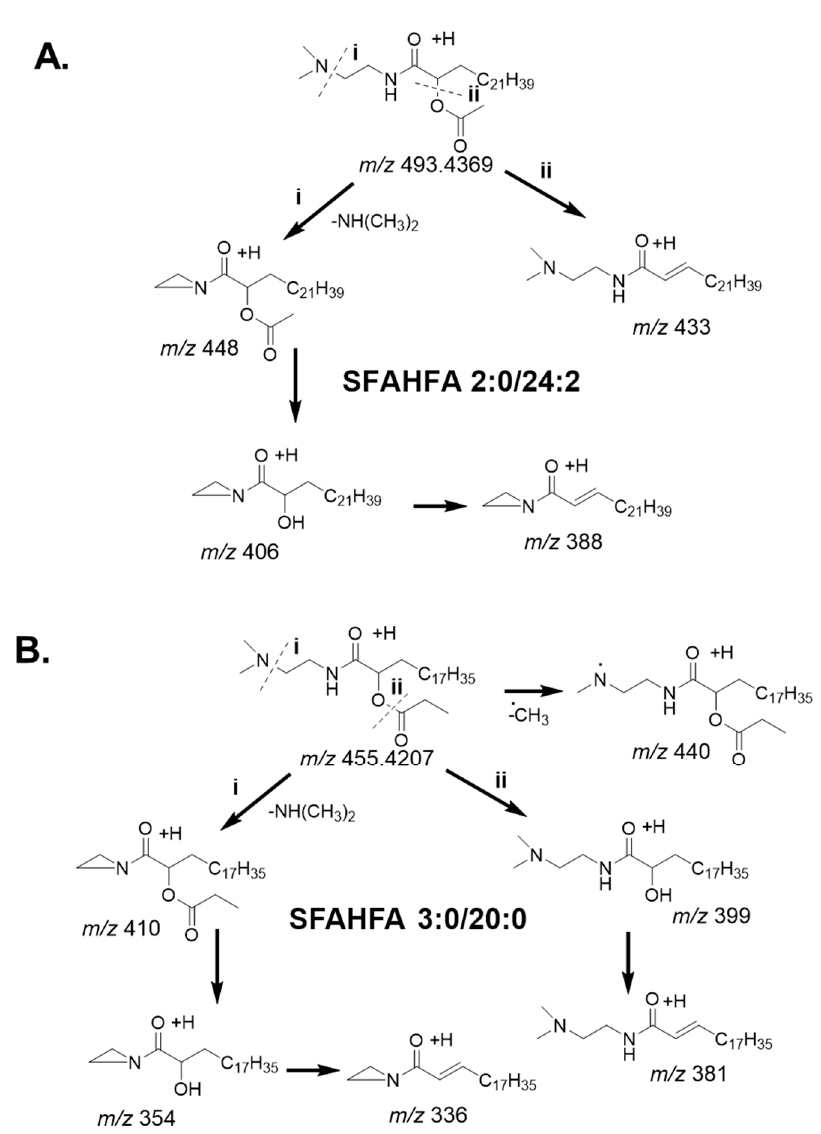
Figure 5. Plausible fragmentation pathway of DMED-labeled SFAHFA 2:0 / 24:2 ( A ) and SFAHFA 3:0 / 20:0 ( B ).